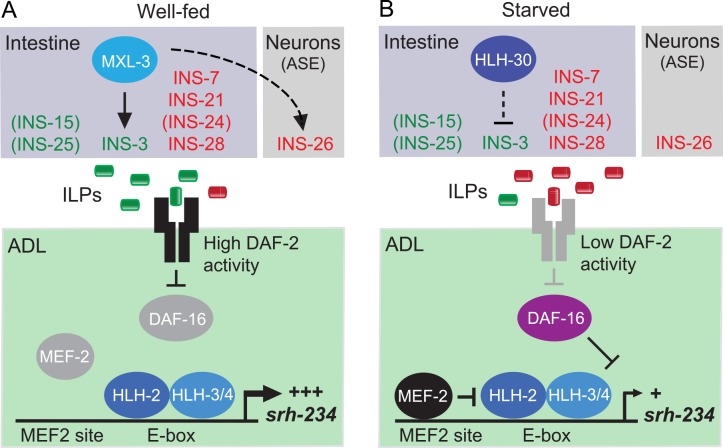
An intestine-to-neuron model for regulation of srh-234 expression in ADL as a function of feeding state.Changes in expression of srh-234 are directed by multiple cell-autonomous and non-cell-autonomous transcriptional modules. In ADL neurons, one module consists of a MEF-2 transcription factor and its MEF2 binding site, and the other module consists of a bHLH heterodimer (e.g. HLH-2/3, and HLH-2/4) and its bi-partite E-box binding site. When fed (A), MEF-2 activity is low and is prevented from repressing HLH-2/3/4 factors, and expression of srh-234 in ADL is increased. When starved (B), MEF-2 is no longer inhibited, allowing binding to the MEF2 site in srh-234 (AGTTATATTTAA), which in turn represses HLH-2/3/4-mediated activation of srh-234 at the E-box site (CACCTG), ultimately leading to the decrease in srh-234 expression. In addition to cell-autonomous mechanisms, the bHLH factors MXL-3 and HLH-30 act in the intestine to remotely regulate changes in srh-234 expression via the DAF-2/DAF-16 insulin pathway acting in ADL. When fed (A), MXL-3 activity is high in the intestine (low HLH-30 activity) and increases srh-234 expression, whereas when starved (B), HLH-30 activity is high in the intestine (low MXL-3 activity) and represses the expression of srh-234 in ADL. The combined action of ILPs from different tissues (the intestine) and other neurons (e.g. ASE) regulated by mxl-3-dependent (e.g. ins-3, ins-26) or independent mechanisms results in either high or low DAF-2 activity, which in turn modulates srh-234 expression in ADL.